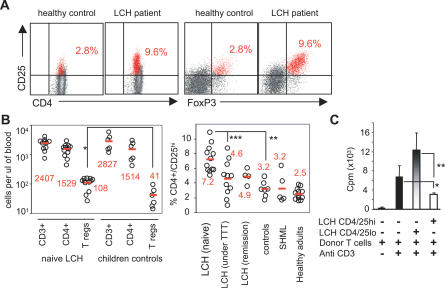
Regulatory CD4+ CD25+ FoxP3+ T Cells Are Expanded in the Peripheral Blood of LCH Patients(A and B) Flow cytometry analysis of CD4+/CD25hi FoxP3high cells in the blood of LCH patients in comparison to healthy controls. (A) Representative dot plots from the blood of one patient and one control. (B) CD3 and CD4 lymphocyte counts were similar in naïve (untreated) LCH patients at diagnosis and in control children, but the absolute number and the frequency of T-regs were significantly higher in the blood of naïve LCH patients at diagnosis than in patients with LCH under treatment, in control children, and in children with SHML. *Chi-squared = 7.125 with 1 df, p = 0.0076; **Chi-squared = 13.714 with 1 df, p < 0.001; ***Chi-squared = 6.682 with 1 df, p = 0.0097.(C) Regulatory activity of CD3+ CD4+ CD25hi T cells isolated from the blood of LCH patients. Proliferation of control T cells (Donor T cells) induced by soluble OKT3 (Anti CD3) in the presence of CD14+ monocytes was inhibited by the addition of sorted CD3+ CD4+ CD25hi T cells (LCH CD4/CD25hi) isolated by positive selection from the blood of a patient with LCH, but not by CD3+ CD4+ CD25low T cells (LCH CD4/25lo) isolated from the blood of the same patient. *p < 0.02, **p = 0.01.